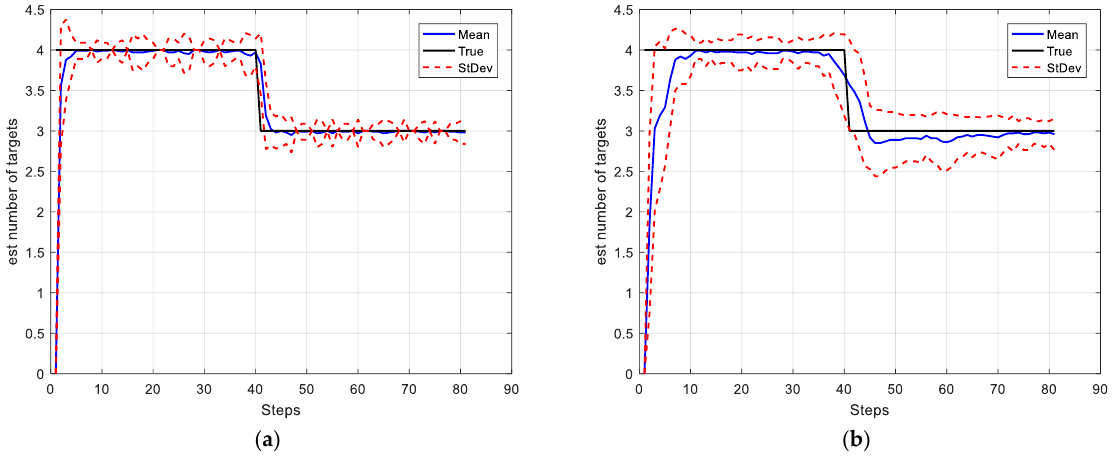
Figure 5. The standard deviation range value and the mean value of the estimated number of targets of BGM-PMBM filter ( a ) 𝑃 𝐷 = 0.94 , 𝜆 𝜅 = 10 ; ( b ) 𝑃 𝐷 = 0.68 , 𝜆 𝜅 = 10 .